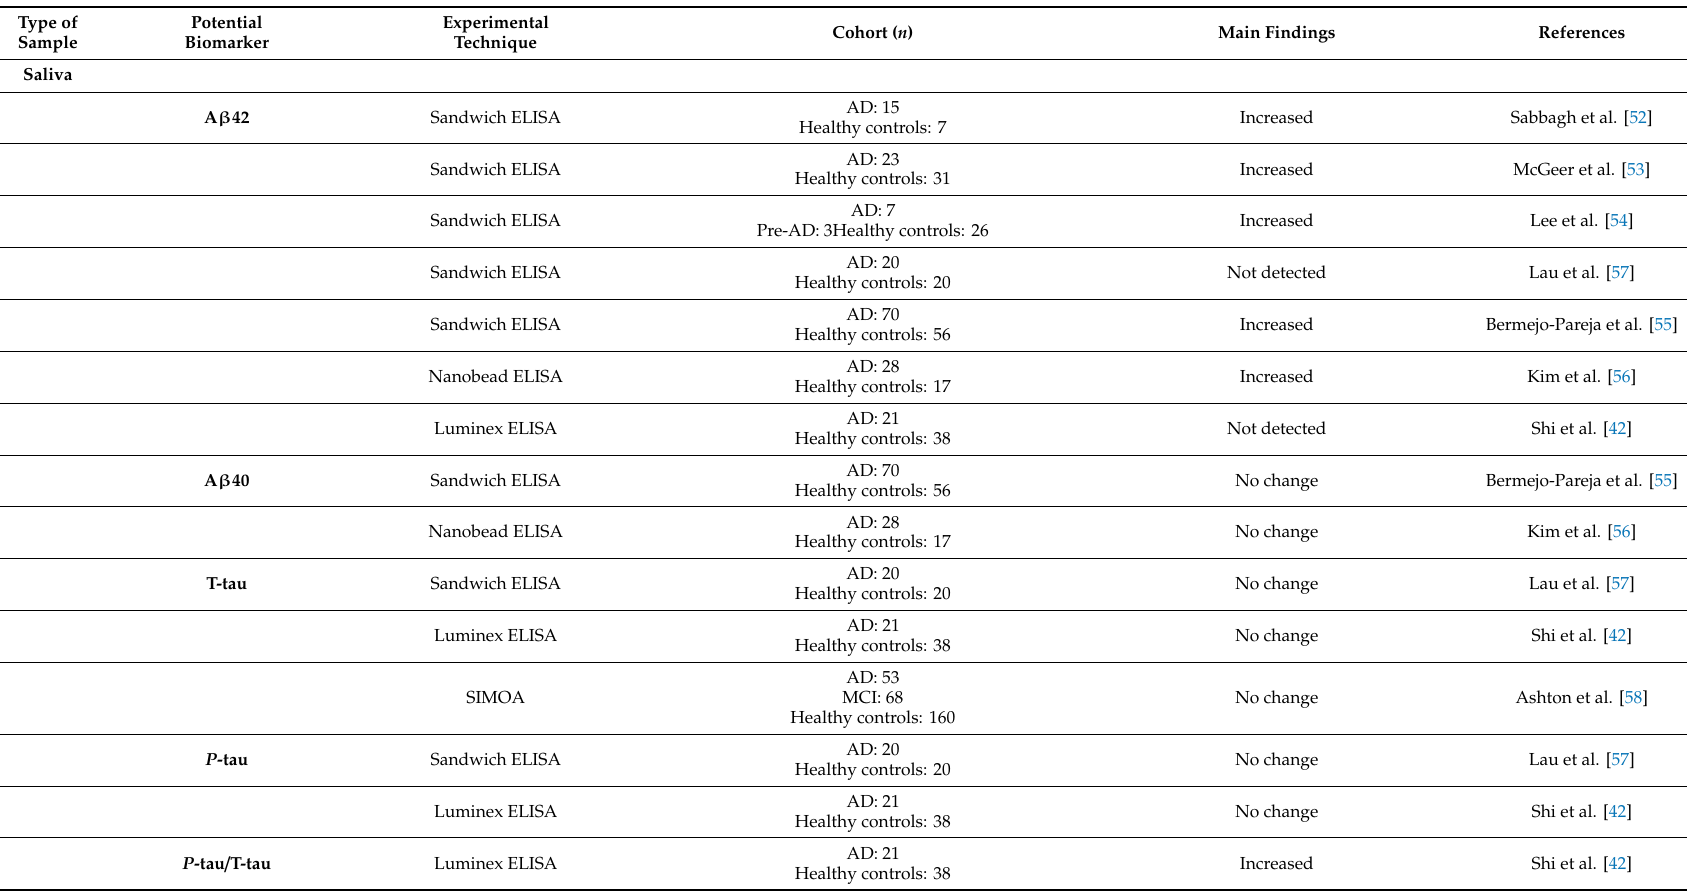
Table 2. Comprehensive table of our literature review. Potential biomarkers, type of non-invasive sample used (saliva or buccal cells), experimental techniques, number of participants and the main findings for each separate study are all